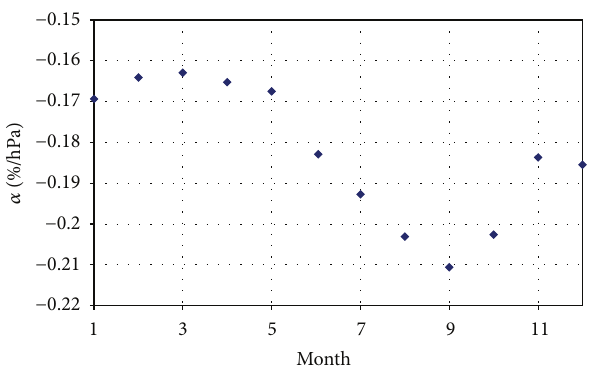
Figure 4: The monthly variations of 𝛼 [%/hPa] over Riyadh for the whole study period.